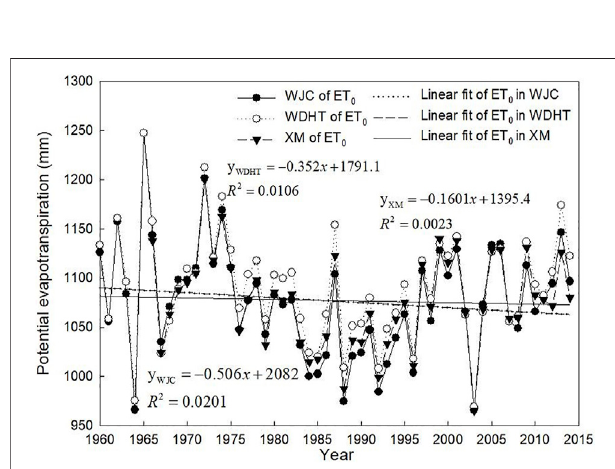
FIGURE 4 | The variation in ET 0 in the Kuye River basin during 1960- 2014.